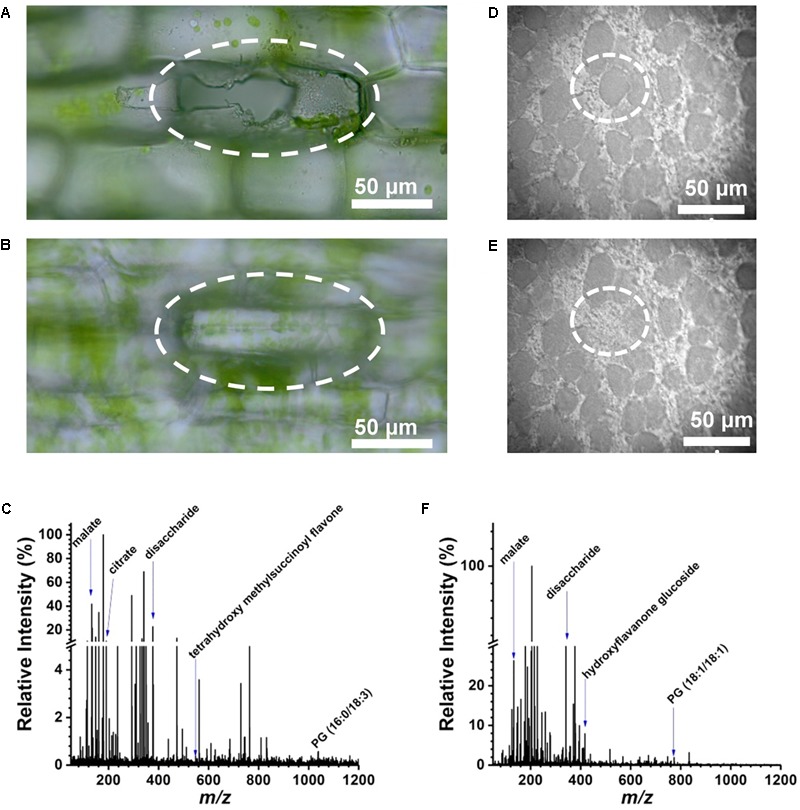
Selective cell sampling in leaf tissue composed of two cell layers. Focusing on (A) adaxial cell layer and (B) abaxial cell layer of an E. densa leaf blade after an ablation event reveals that only the adaxial cell is sampled. (C) Corresponding negative ion mode mass spectrum from a single cell that exhibits ∼186 spectral features with detected biomolecules ranging from amino acids to secondary metabolites. Microscope image of single infected cell in G. max root nodule section (D) before and (E) after ablation of circled cell. (F) Negative ion mass spectrum of the ablated G. max cell.